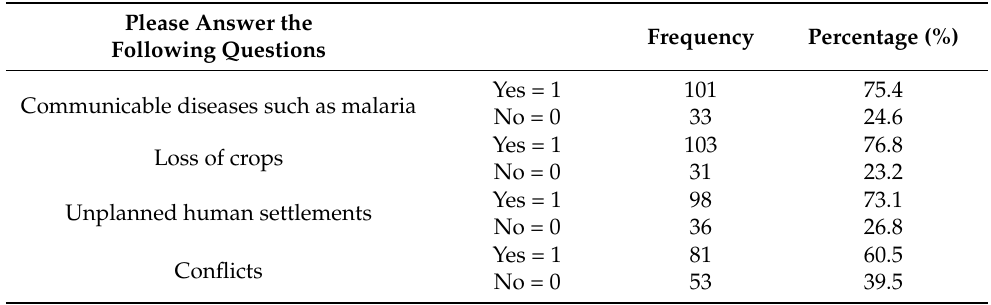
Table 5. Basic understanding of the effects of LSAI on human health-related outcomes, loss of crop production, unplanned human settlements, and social